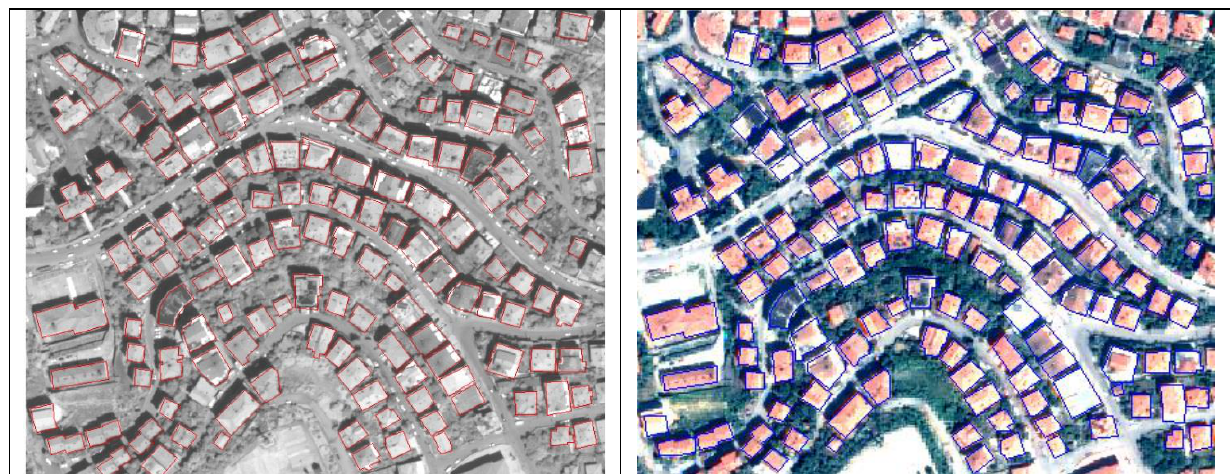
Figure 8. Object extraction from Quickbird pan and pan-sharpened images